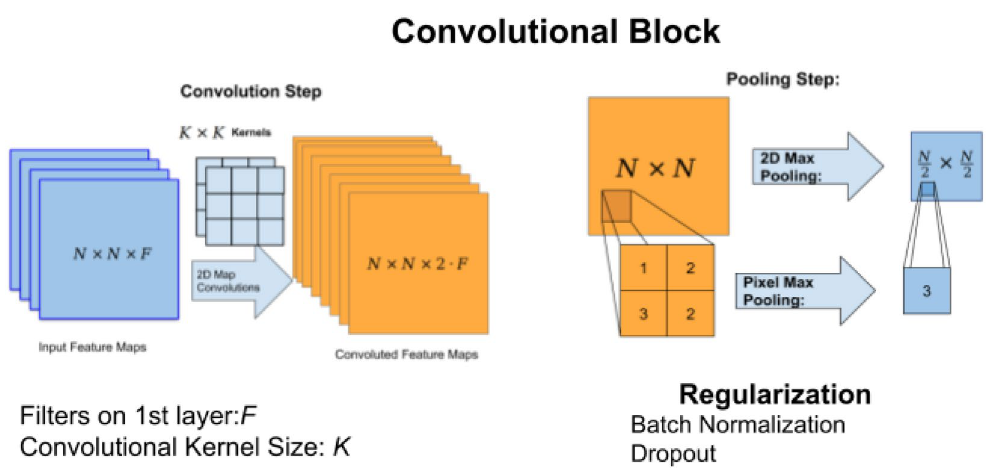
Figure 4. High level description of the CNN architecture.